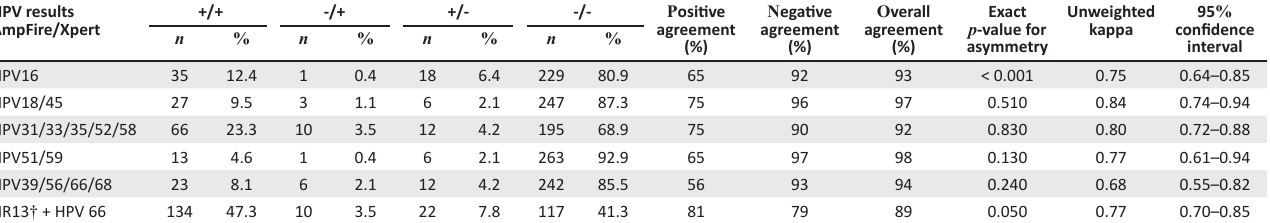
TABLE 1: Agreement for detection of human papillomavirus overall and HPV types grouped according to the Xpert HPV assay between Xpert HPV assay and AmpFire HPV genotyping assay, Rwanda, June 2018 - June 2019. HPV results AmpFire/Xpert